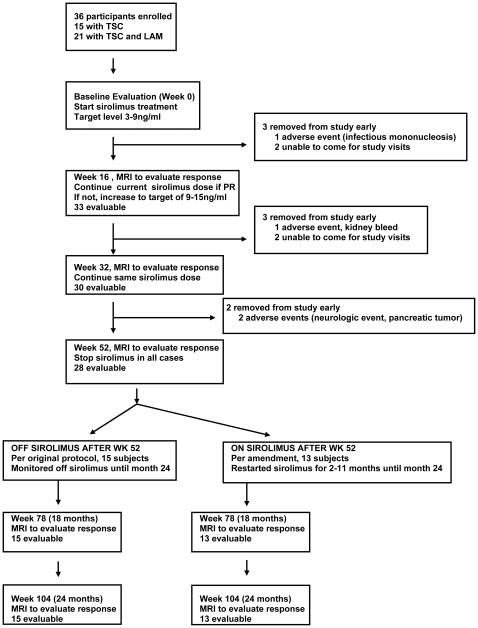
Enrollment Chart.